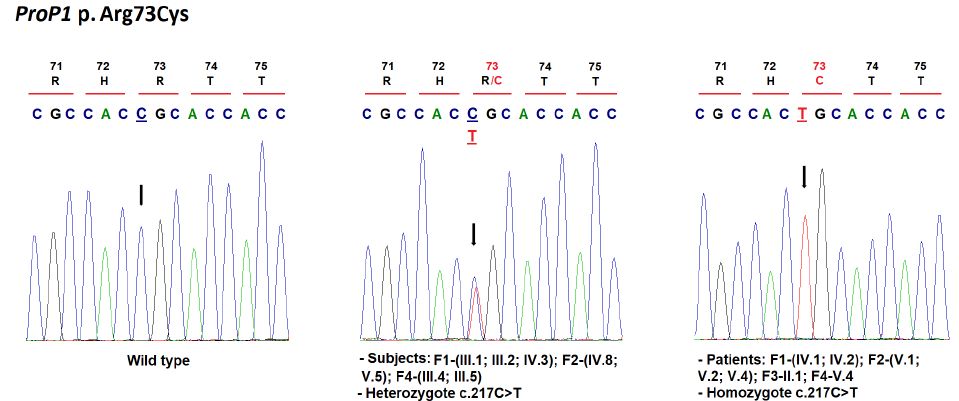
Figure 2. Mutation analysis of the ProP1 gene in familial cases. Electropherogram analysis of ProP1 gene in affected and unaffected individuals. The c.217C > T mutation in exon 2 resulted in substitution of the arginine by cysteine at amino acid position 73. Mutated nucleotide on the chromatographs is in bold, underlined and depicted with an arrow. Amino acid substitution is indicated in red.